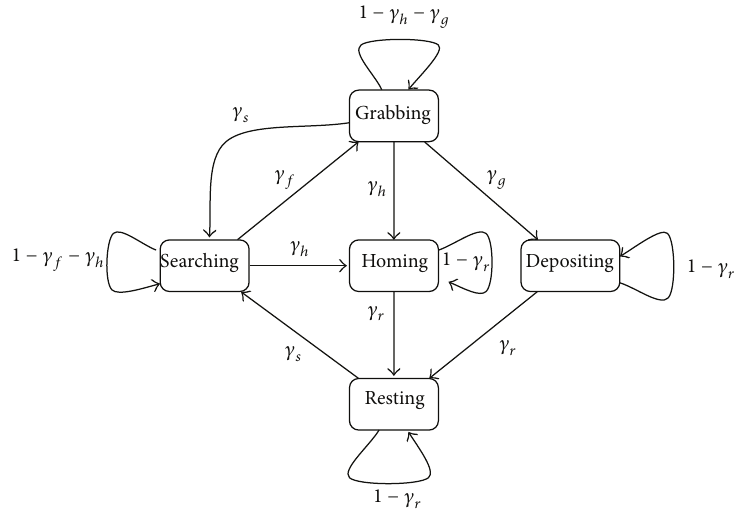
Figure 9: Probabilistic state machine for a foraging